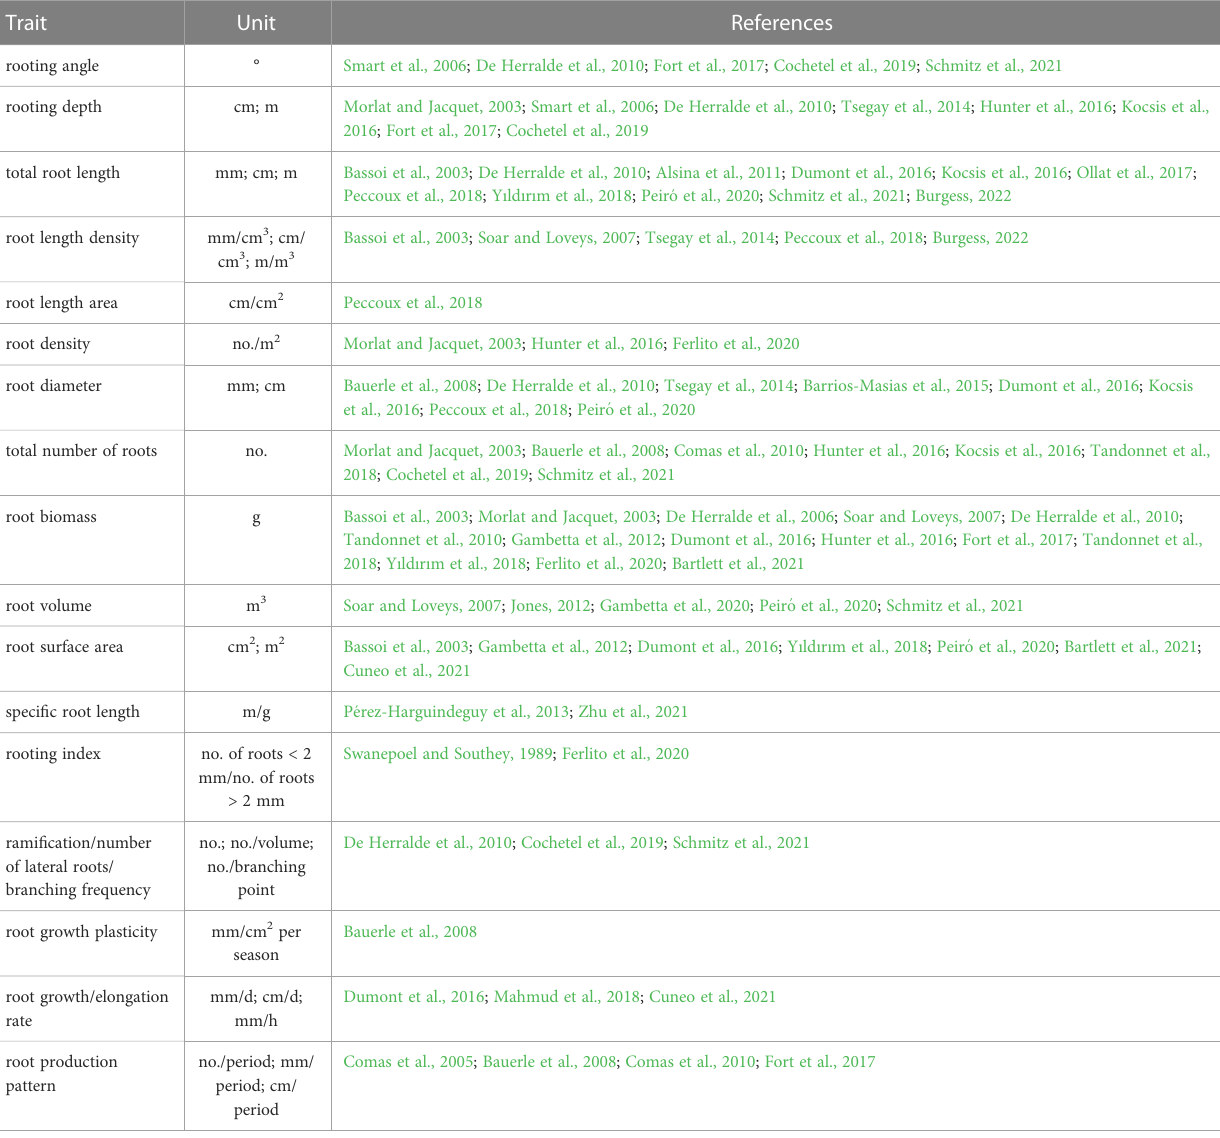
TABLE 1 Overview of root architecture traits commonly used in grapevine research. Trait